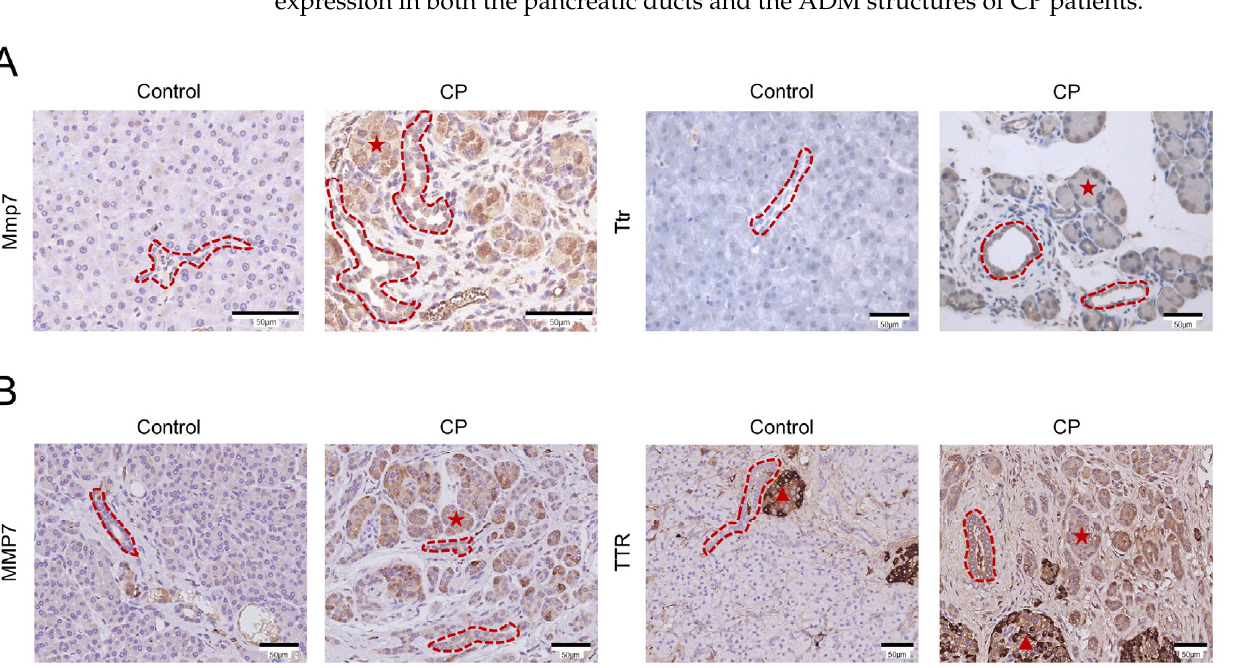
Figure 6. Immunohistochemical analysis of the MMP7 and TTR expression changes in mouse and human CP tissues. ( A ) Immunohistochemical staining of Mmp7 and Ttr in pancreatic tissues from the control and CP mice. ( B ) Representative immunohistochemical images of MMP7 and TTR in morphologically well-preserved pancreatic tissue (from a patient with a pancreatic neuroendocrine tumor) and pathological pancreatic tissue sections obtained from a patient with CP. The red dotted lines represent pancreatic ducts, the red pentagrams represent ADM structures, and the red triangles represent human islets of Langerhans. Scale bar = 50 μ m.